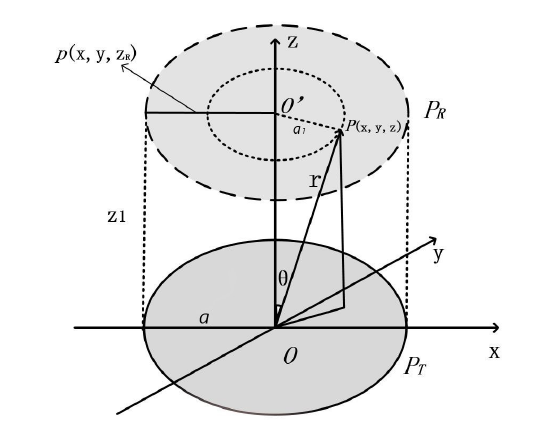
Figure 3. Piston acoustic source